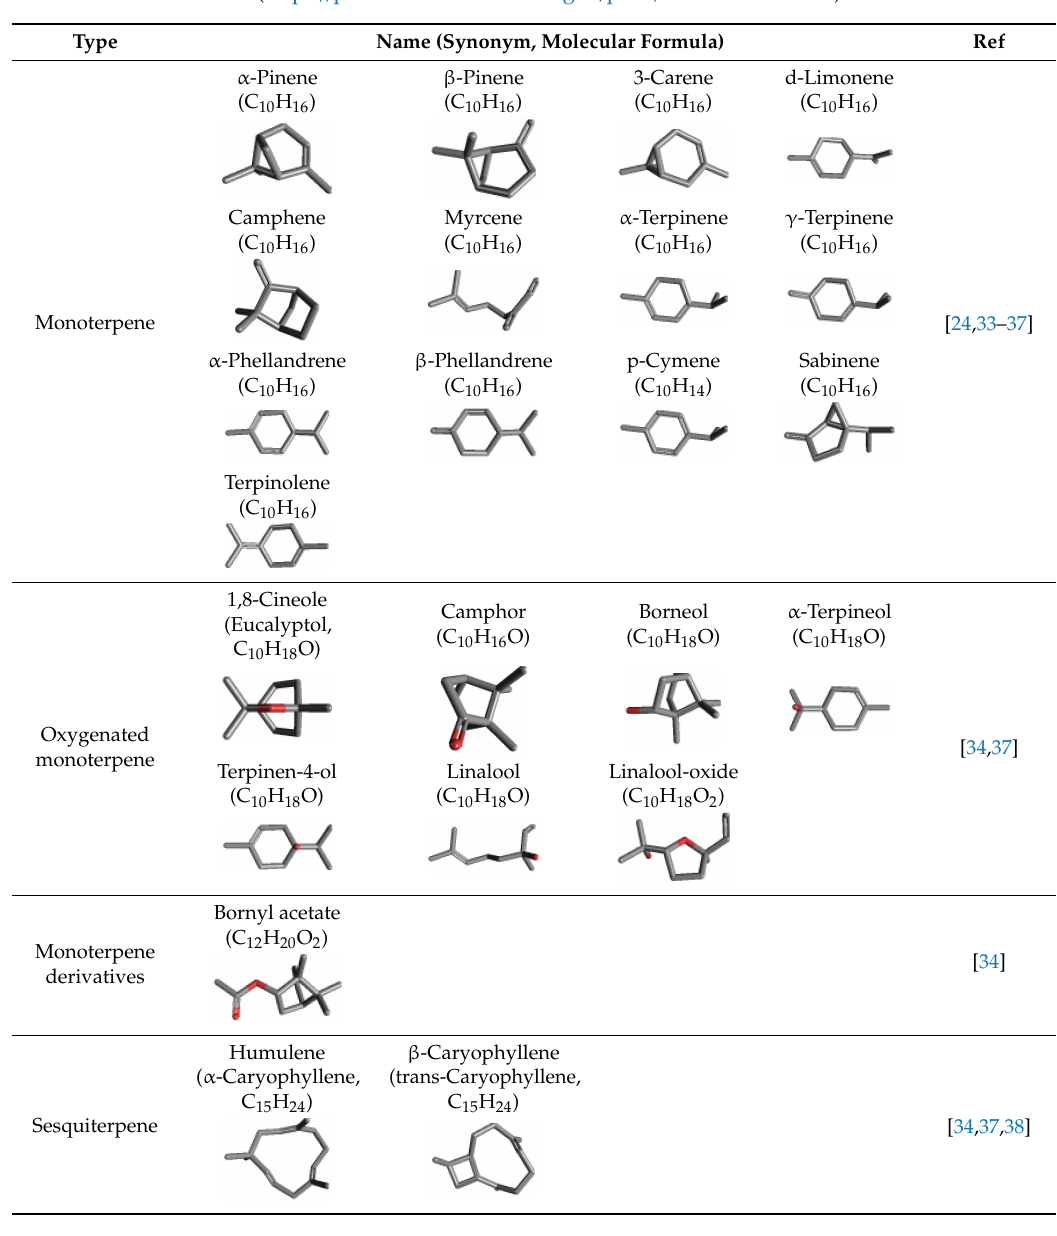
Table 1. General types of terpenes and terpenoids emitted from forested areas. Some of the well-known synonyms and molecular formulas are shown in brackets. All structures of the compounds are from the PubChem 3D viewer database (https: // pubchem.ncbi.nlm.nih.gov), in which carbons and oxygens are colored in gray and red, respectively. For more details on the drawing, refer to the description in the Pubchem web site (https: // pubchem.ncbi.nlm.nih.gov / pc3d /